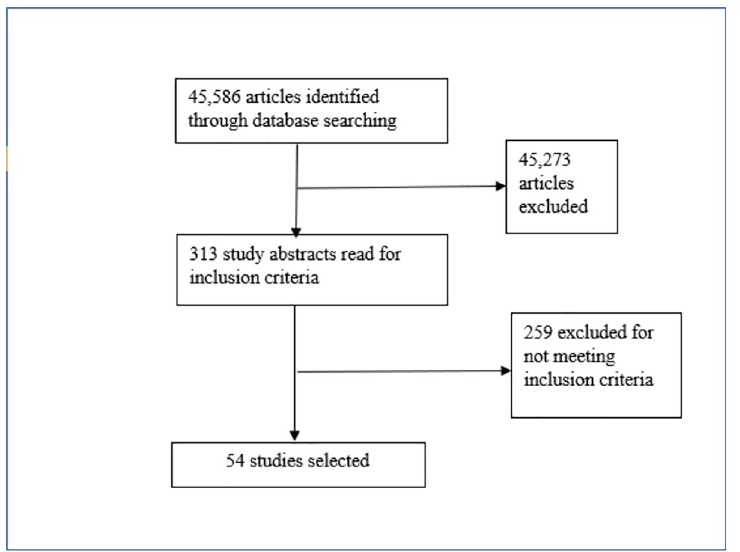
Fig 1. PRISMA flow diagram for scoping